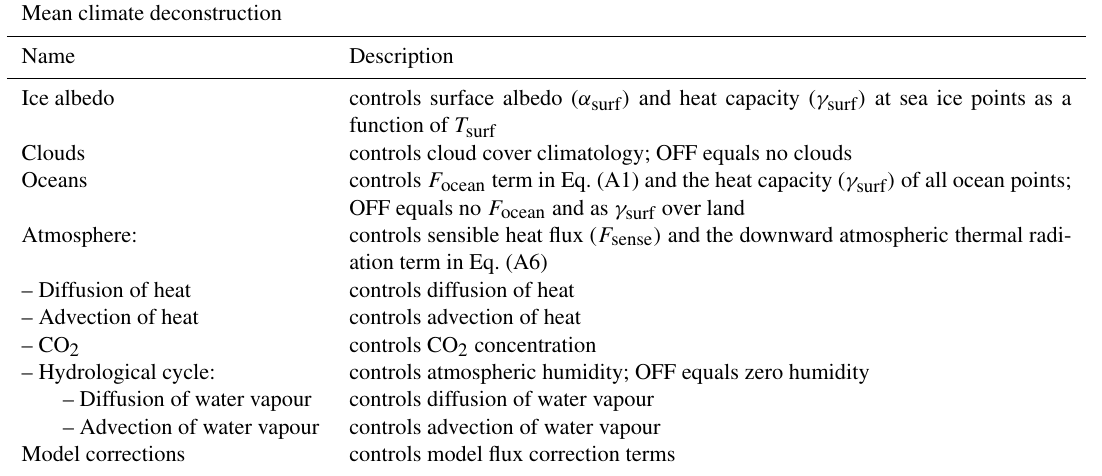
Table 1. Processes (switches) controlled in the sensitivity experiment for the mean climate deconstruction. Indentation in the left column indicates that process switches are dependent on the switches above being